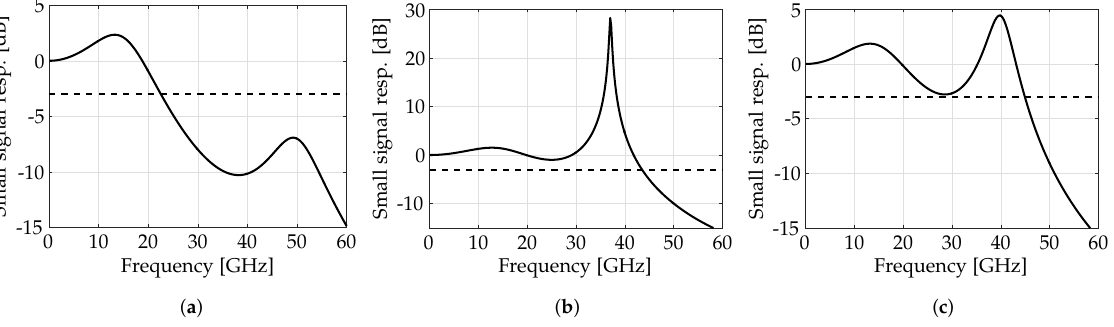
Figure 3. Examples of small signal modulation responses obtained with the finite difference traveling wave (FDTW) model for cavity parameters and phase tuning used in Figure2. ( a ) φ S = 0 and f PPR = 49GHz, ( b ) φ S = π and f PPR = 37GHz and ( c ) φ S = π /2 and f PPR =